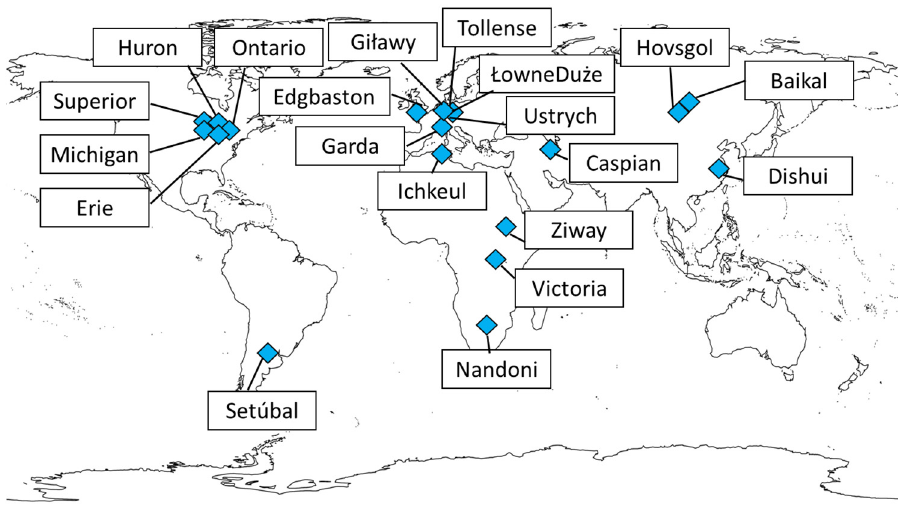
Figure 3. The locations of the study areas are indicated by rhombus and the names of the lakes are shown in the labels.